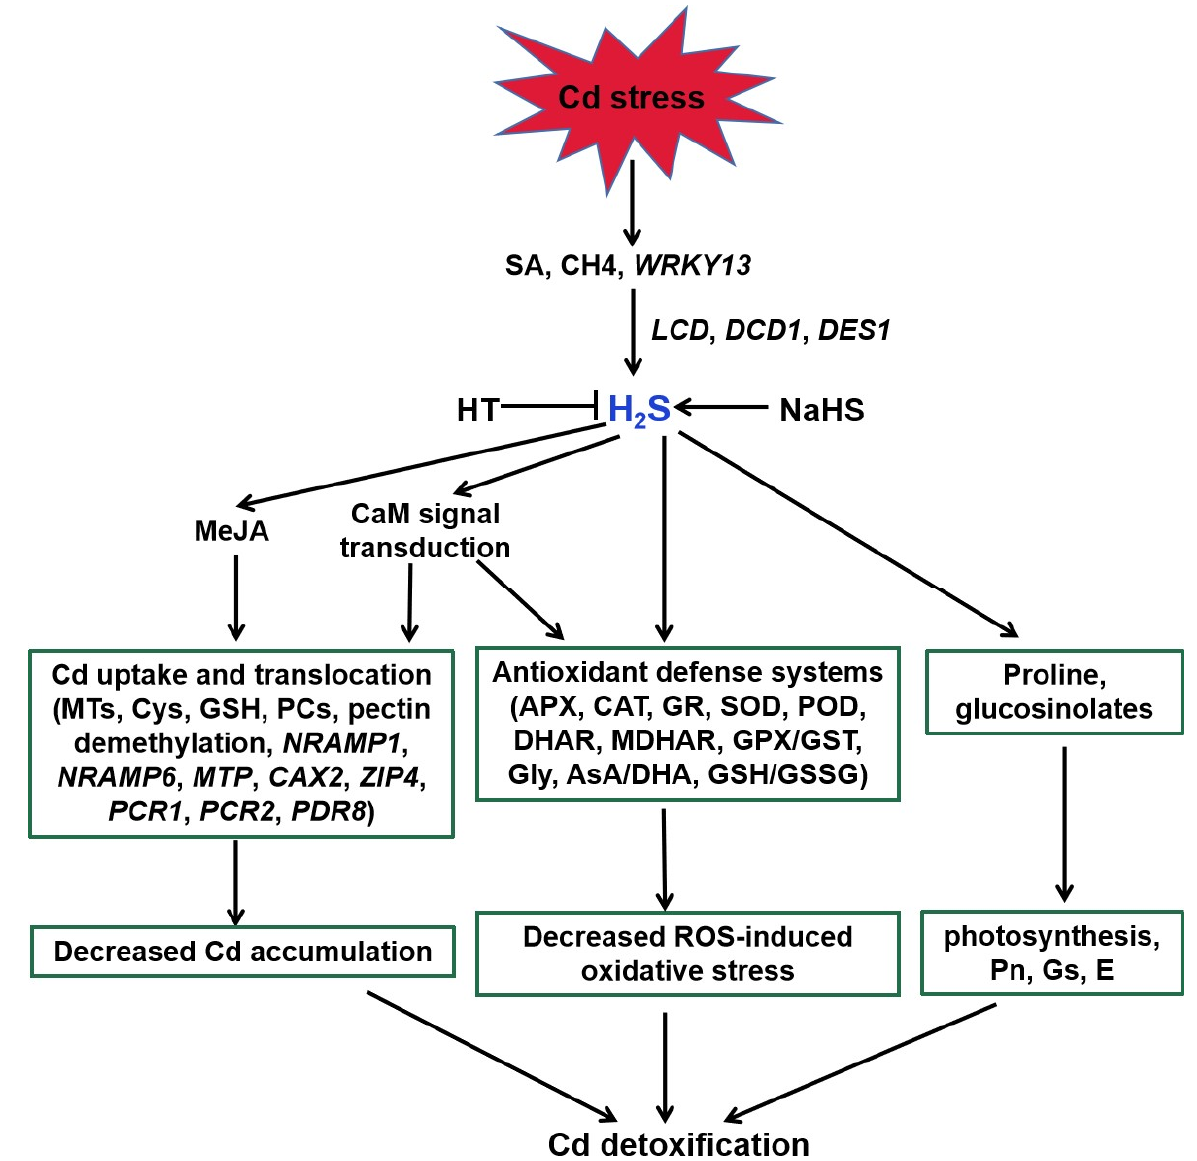
Figure 3. Function of H 2 S in plant responses to Cd stress. SA, CH 4 , and WRKY13 are involved in Cd-induced H 2 S generation. H 2 S enhances the antioxidant defense systems to decrease the ROS accumulation, regulates the transcripts of genes related to Cd uptake and translocation to reduce the Cd accumulation, and increases proline and glucosinolates in response to Cd stress in plants. MeJA and Ca participate in the above regulatory pathways. SA, salicylic acid; CH4, methane; HT, hypotaurine; LCD, L-cysteine desulfhydrase; DCD, D-cysteine desulfhydrase; DES1 , L-cysteine desulfhydrase 1; MeJA, methyl jasmonate; CaM, calmodulin; NRAMP1 , natural resistance-associated macrophage protein1; NRAMP6 , natural resistance-associated macrophage protein6; MTP , metal tolerance protein; CAX2 , vacuolar cation/proton exchanger2; ZIP4 , zinc-iron permease4; PCR1 , plant cadmium resistance1; PCR2 , plant cadmium resistance2; PDR8 , pleiotropic drug resistance8.